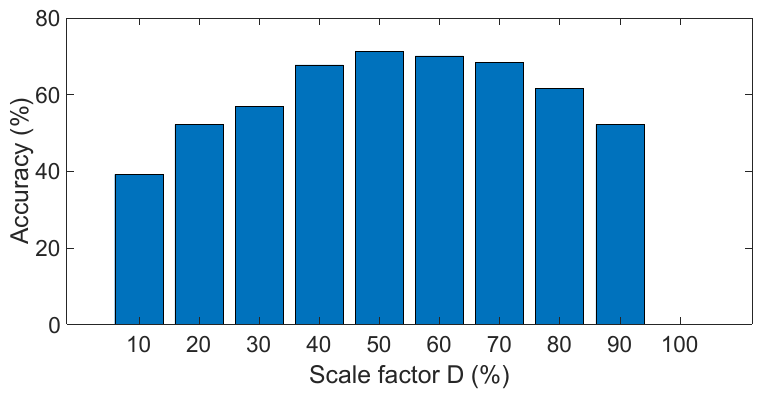
Figure 7. Scale factor statistical analysis.